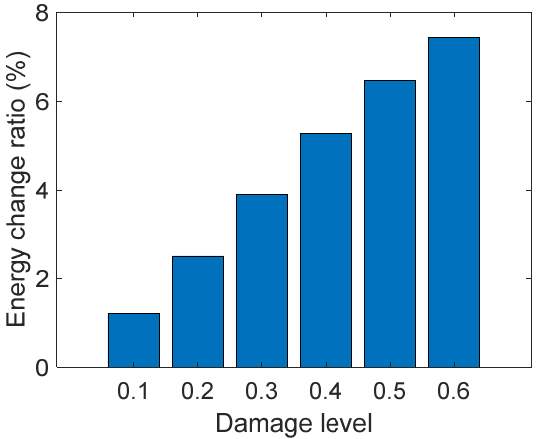
Figure 18. Energy change ratio versus different damage levels .